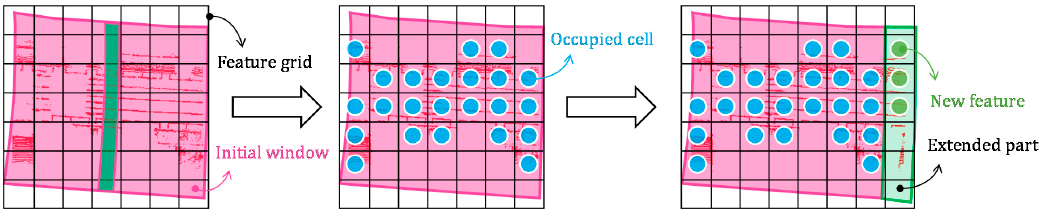
Figure 16. The procedure of defining the window length for the target patch. First, the initial window around the target patch is divided into a feature grid ( left ). Second, the occupied cells—those containing five or more points—are calculated ( middle ). The window is extended by adding new patches until the number of occupied cells meets or exceeds the required feature count ( right ).